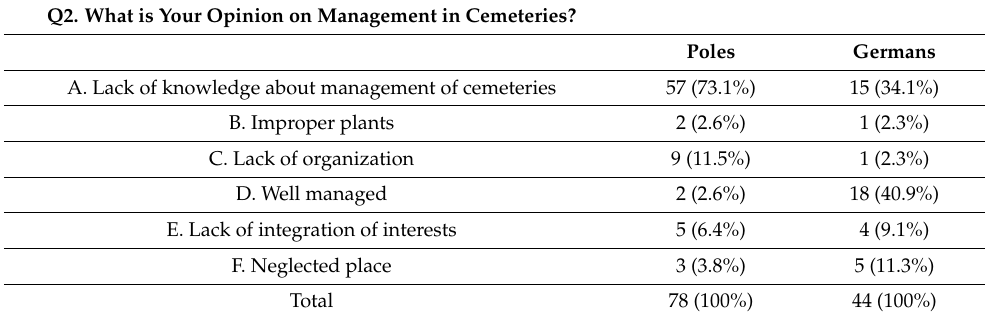
Table 3. Respondents’ opinion on management aspects of selected cemeteries in Ł ó d´z and Leipzig.